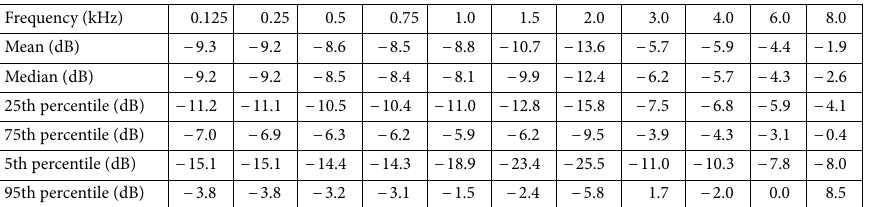
Table 2. Displacement amplitude difference between standard actuator response measured unloaded on the bench to actuator displacement measured intraoperatively after implantation (N = 66). A decrease in output amplitude by the surgery is indicated by negative values while an increase results in a positive